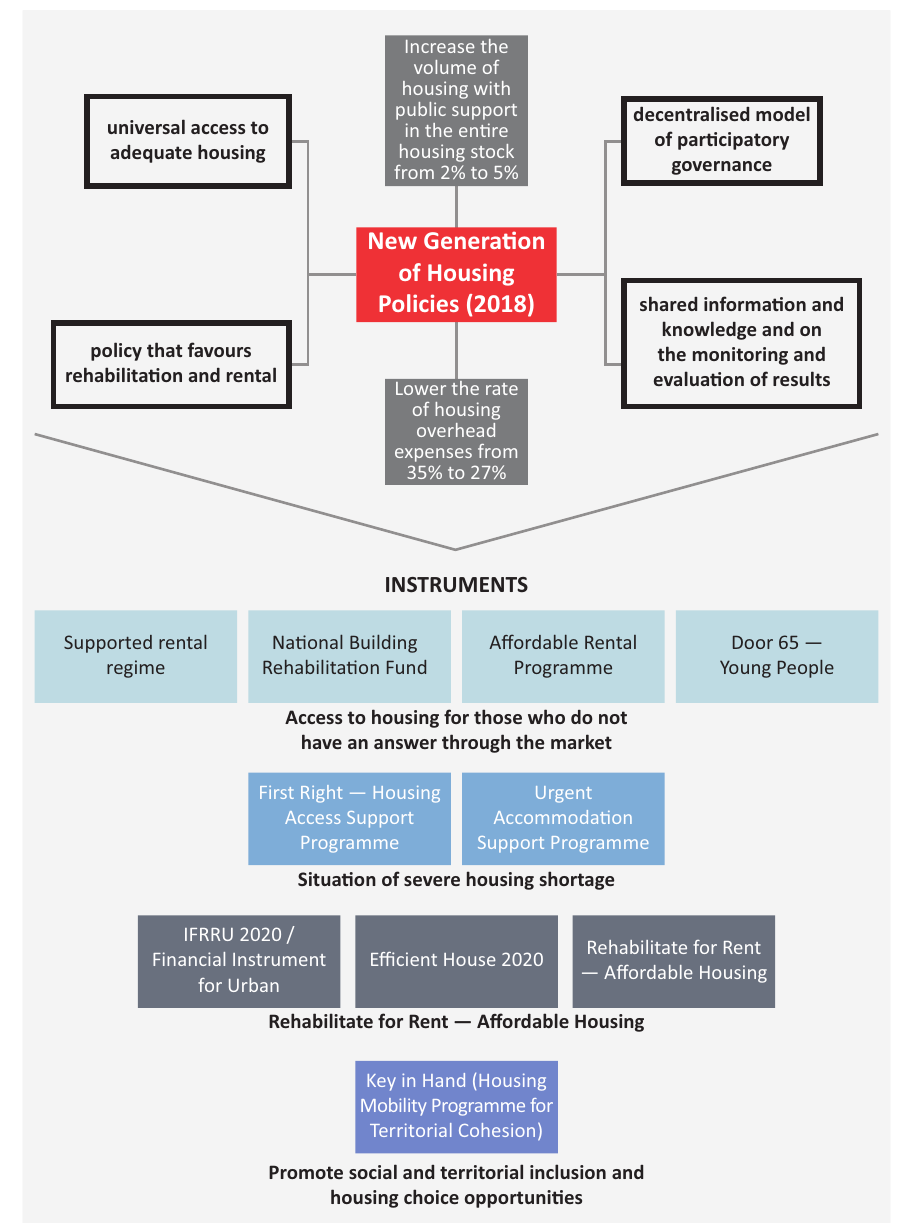
Figure 9. New Generation of Housing Policies (2018): Goals, principles, and key instruments. Urban Planning, 2022, Volume 7, Issue 1, Pages